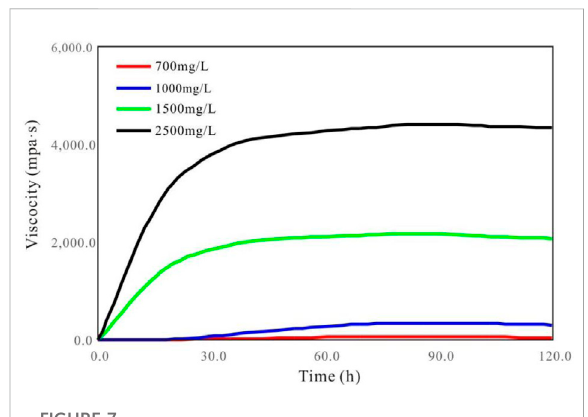
FIGURE 7 Variation of viscosity with time of polymer gel pro fi le control agent system under shearing